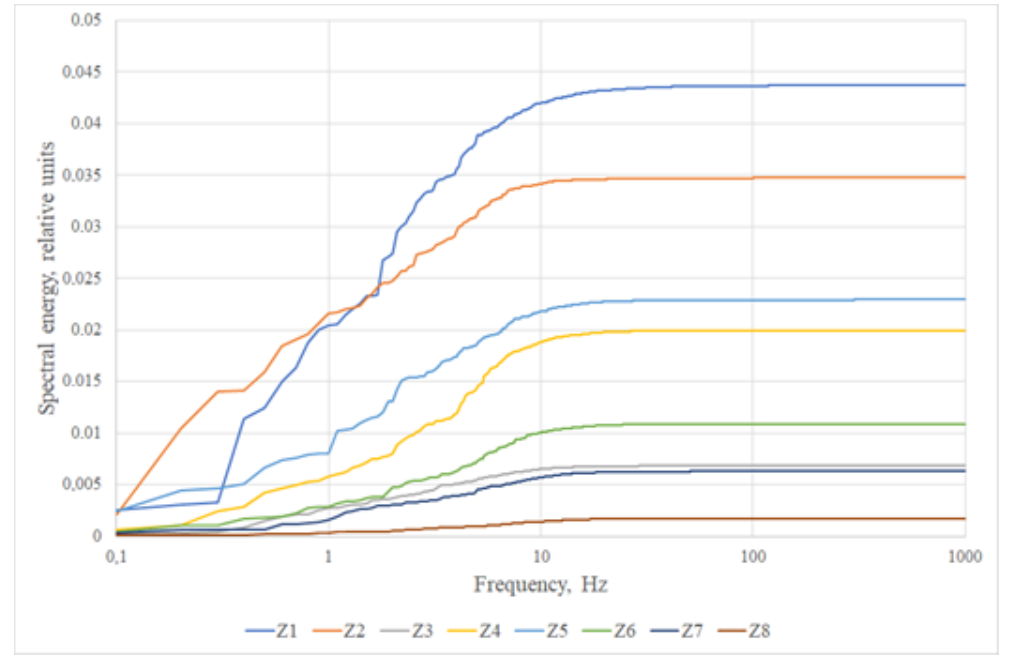
Figure 10. The spectral energy for first eight Zernike polynomials.